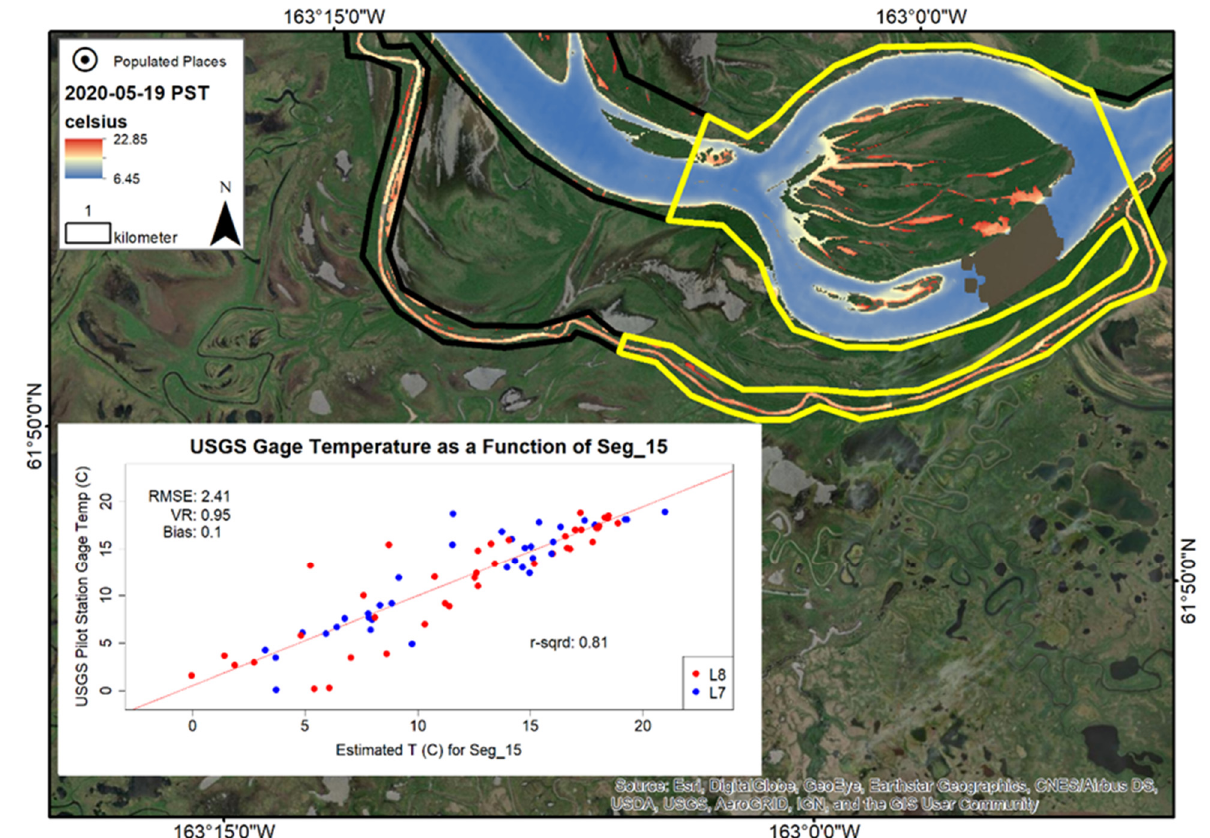
Figure A13. The Yukon River is divided into two main channels, and a minor slough within segment 15. Hills Slough is the most northern channel while the main stem of the Yukon passes to the south of Hills Island. A minor slough is the most southerly feature of the Yukon in this segment. It is identified both as Kashunuk Slough and Driftwood Slough on USGS quadrangle maps. The pST coverage is 100% within this section. At high water, channels and backwaters are flooded on Hill Island as depicted above. At lower stages, these water features are dry. Correlation between estimated and measured water temperature is good (RMSE = 2.41 °C, r 2 = 0.804).